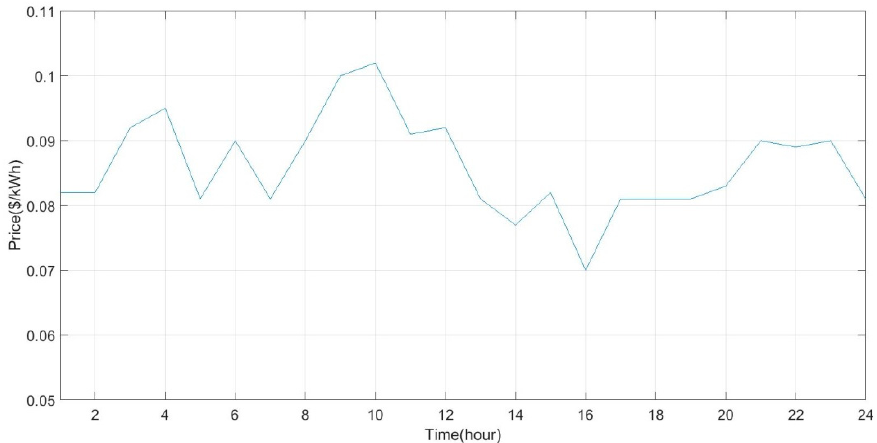
Figure 3. Expected day-ahead market price curve for scenario generation. Table 2. Simulation parameters.